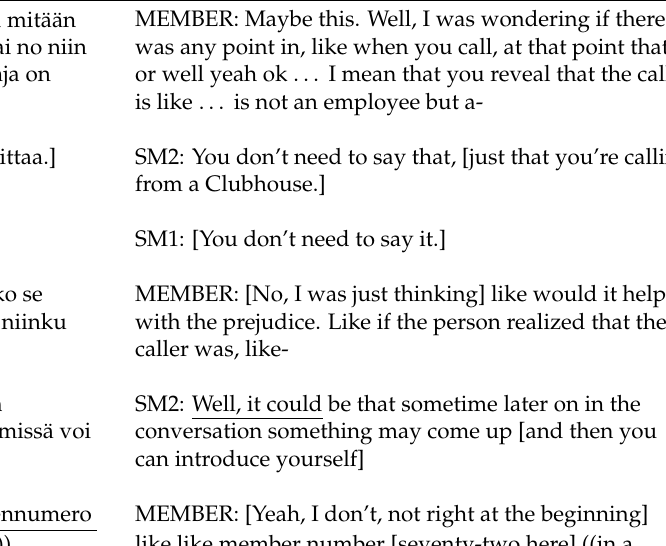
Table 5. Excerpt 2b